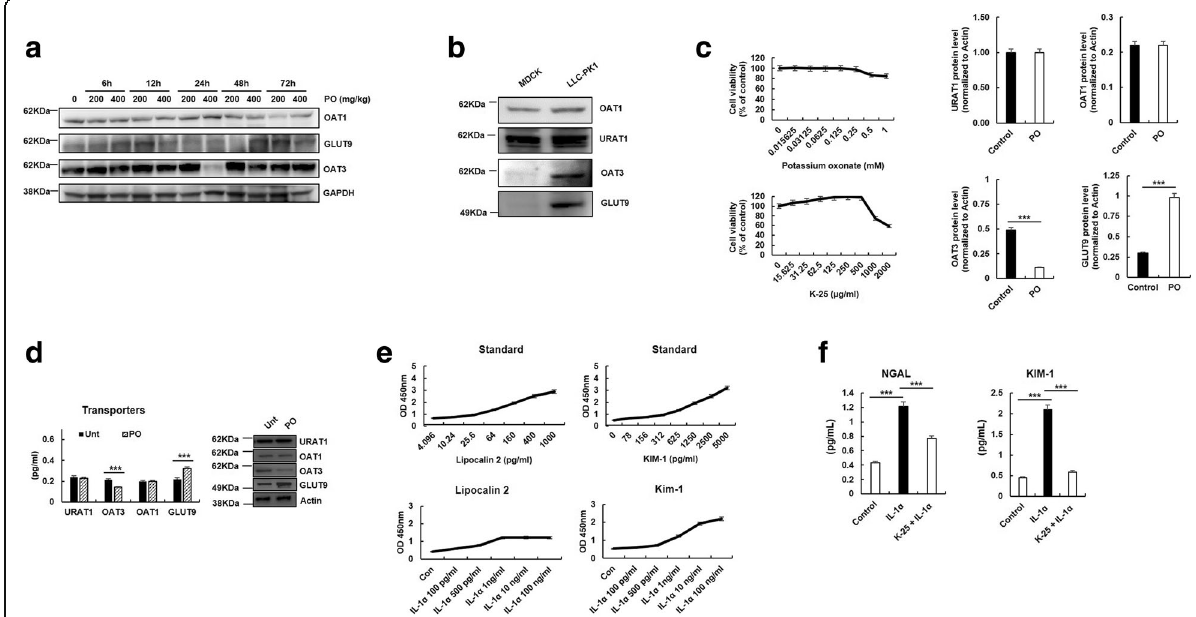
Fig. 3 Analysis of transporters and inflammatory factors. a Protein levels of transporters OAT1, OAT3 and URAT1 were determined using immunoblot analysis in kidney cell lines. b After treatment of LLC-PK1 cells with PO and K-25 for 24h, cell viability was measured using the cell viability assay. c Protein levels of transporters OAT1, OAT3, GLUT9 and URAT1 were determined using ELISA and immunoblot analysis in PO-induced LLC-PK1 cells. d Activation of NGAL and KIM-1 by IL-1 α . The protein levels in IL-1 α -treated LLC-PK1 cells were detected using ELISA. e LLC-PK1 cells were stimulated with IL-1 α (10ng/mL) with or without pretreatment with K-25 (0.5mg/mL). f After 24h-incubation, NGAL and KIM-1 levels were measured using ELISA. Values represent mean±standard error of the mean. ** p <0.01, compared to the IL-1 α control. The statistical significance (* p <0.05, ** p <0.01, *** p < 0.001) was determined using ANOVA with Bonferroni